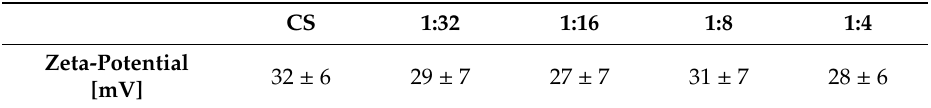
Table 1. Zeta potential of chitosan (CS) and gallium (Ga (III))-CS complex suspensions used for electrophoretic deposition